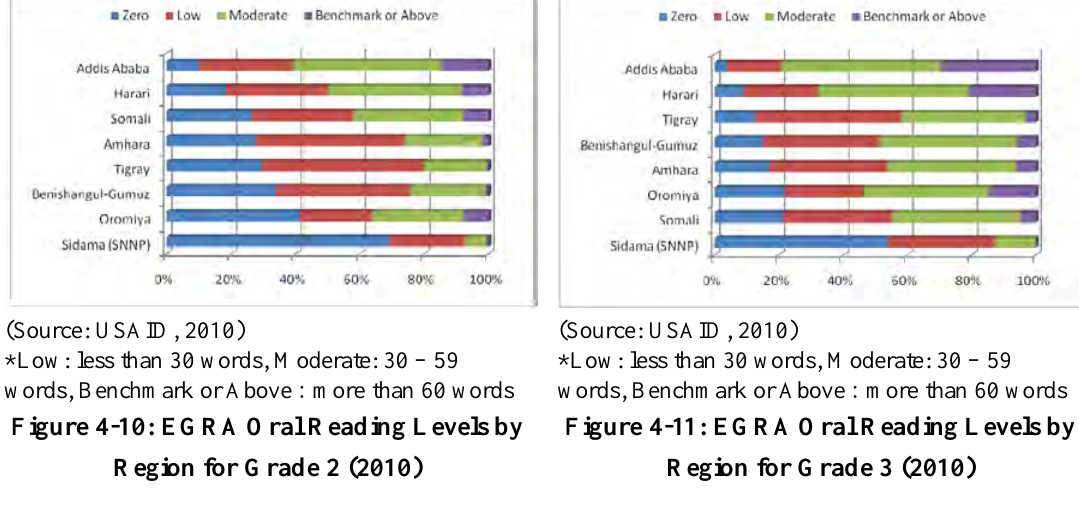
Figure 4-10: EGRA Oral Reading Levels by Region for Grade 2 (2010)